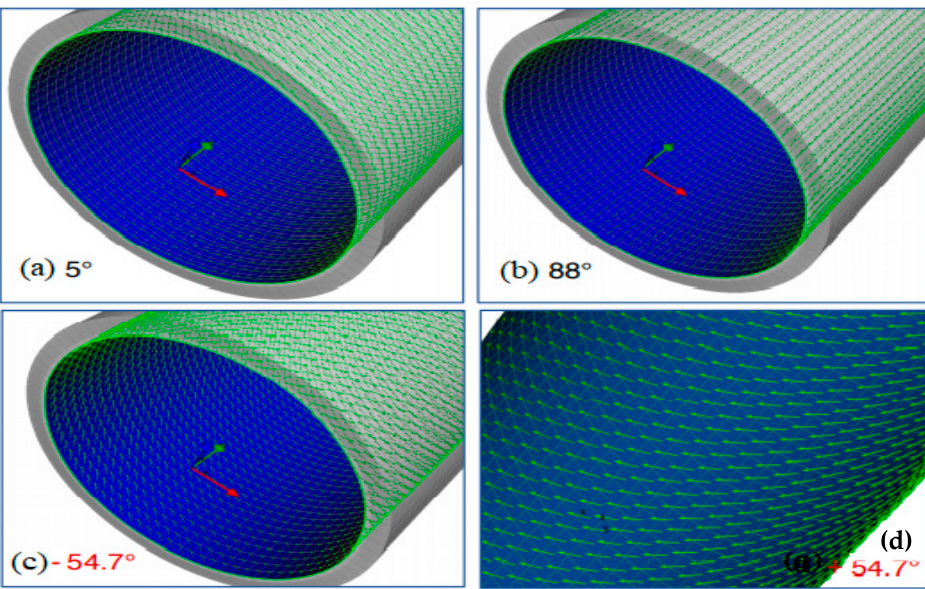
Figure 4. Fibre reinforcements for ( a ) axial ply, ( b ) hoop ply, and ( c , d ) off-axis plies.